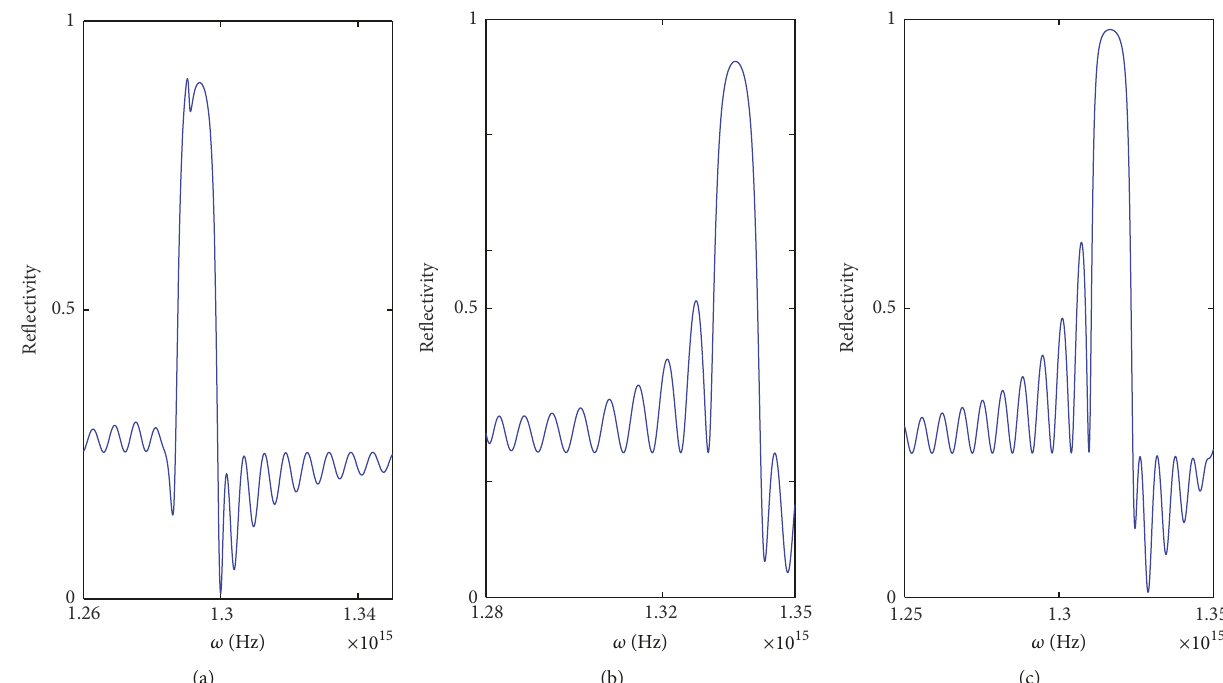
Figure 2: Reflectivity of 200-periodic QWs without presence of a strong pump pulse for (a) In 𝑥 Ga 1−𝑥 As/InP, (b) In 𝑥 Ga 1−𝑥 As/GaAs, and (c) In 𝑥 Al 1−𝑥